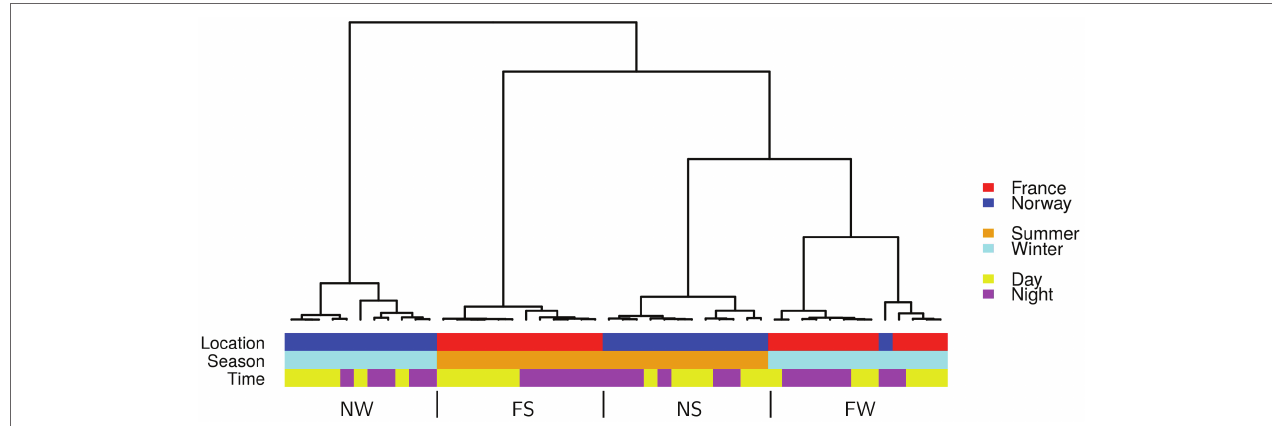
FIGURE 5 | Highly simplified overview of various functions that characterize the specificities in seasonal variation of gene expression in the Norwegian population of Zostera marina . Functions, enzymes and components upregulated in winter are highlighted with a blue background; such upregulated in summer are highlighted with an orange